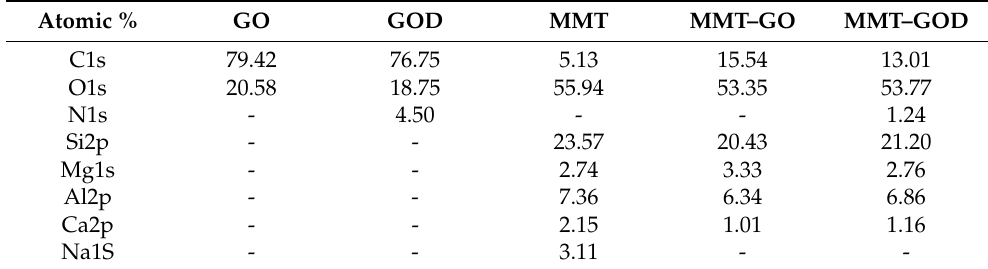
Table 2. Surface elemental composition from XPS for the nanoreinforcing agents.